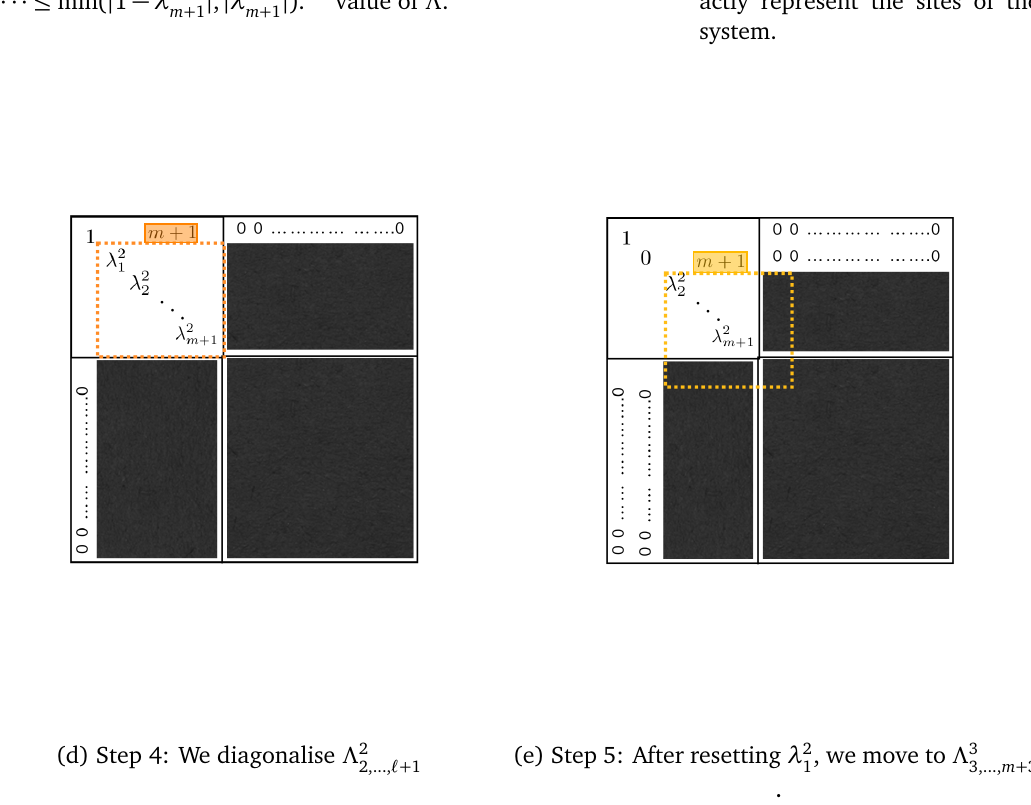
Figure 12: Steps of the algorithm for reducing the bond dimension of a fermionic Gaussian state. The big squares represent the correlation matrix Λ . We repeat this procedure ( N − m ) times then we continue for m steps reducing by one the dimension of the reduced system at each step. At the end one obtains a diagonal matrix with diagonal elements equal to 1 or